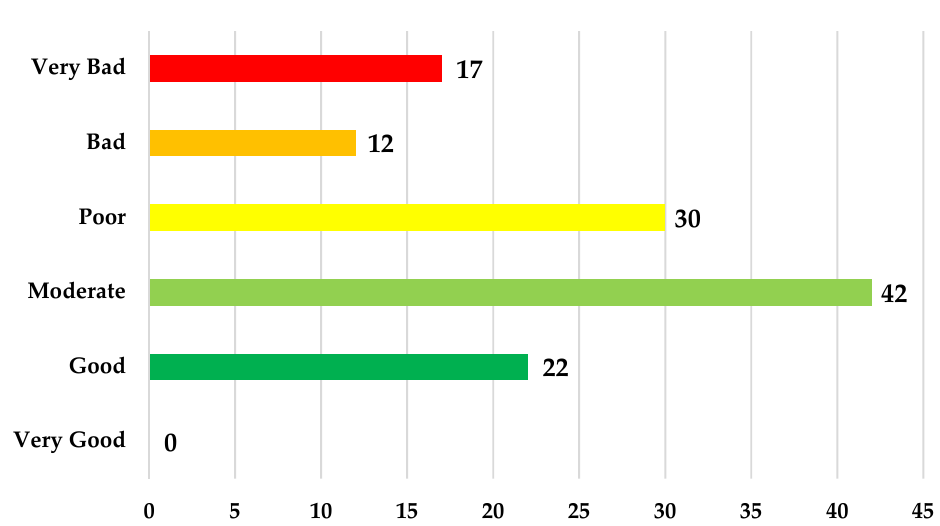
Figure 4. Number of sites per class according to River Quality Index (RQI).